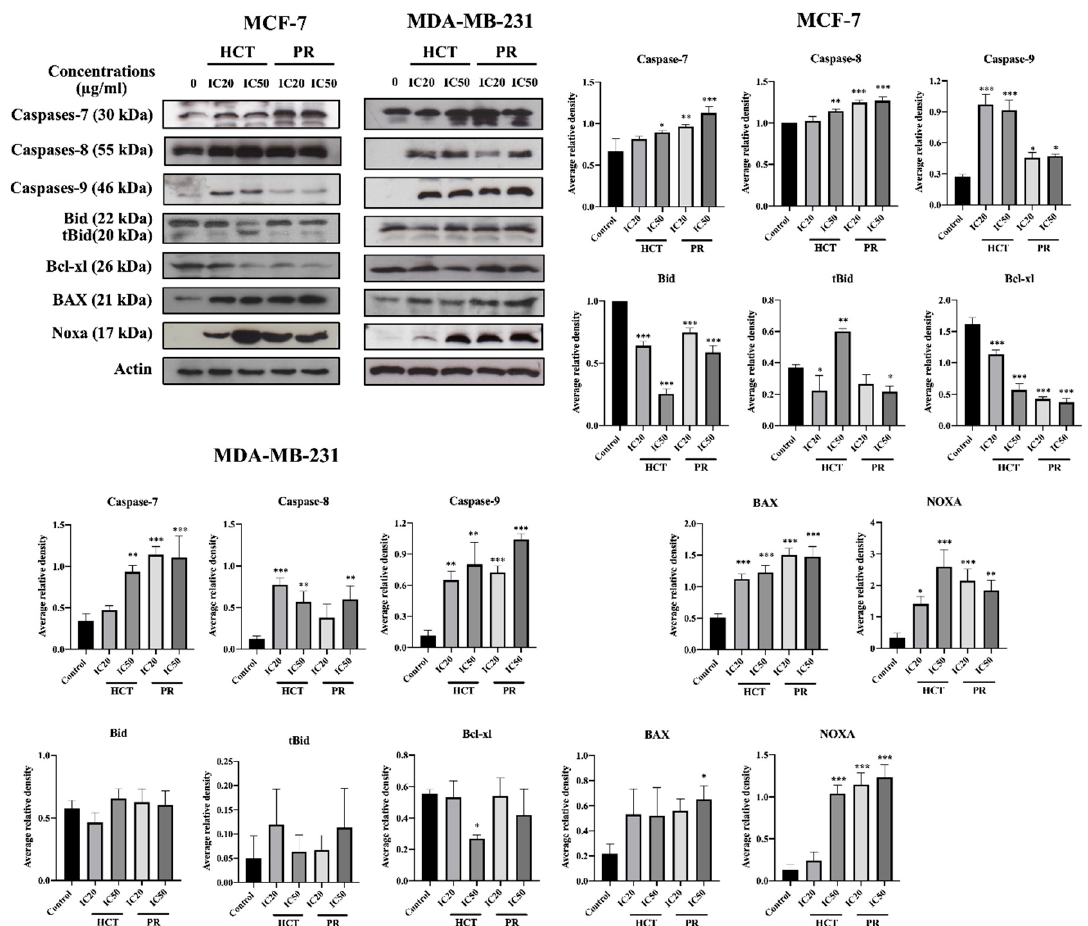
Figure 10. The effects of H. cordata and P. ribesioides extracts on the expression of apoptotic involving proteins in breast cancer cells. MCF-7 and MDA-MB-231 cells were treated with IC20 and IC50 of each ethanolic extract for 24 h, and whole cell lysates were prepared and subjected to Western blotting. The immunoblots were investigated for caspase-7, caspase-8, caspase-9, Bid, tBid, Bcl-xl, BAX and Noxa. β -Actin acted as the loading control. The results are normalized to the control. Data are the means ± SD. * p < 0.05, ** p < 0.01, and *** p < 0.001 vs. control.